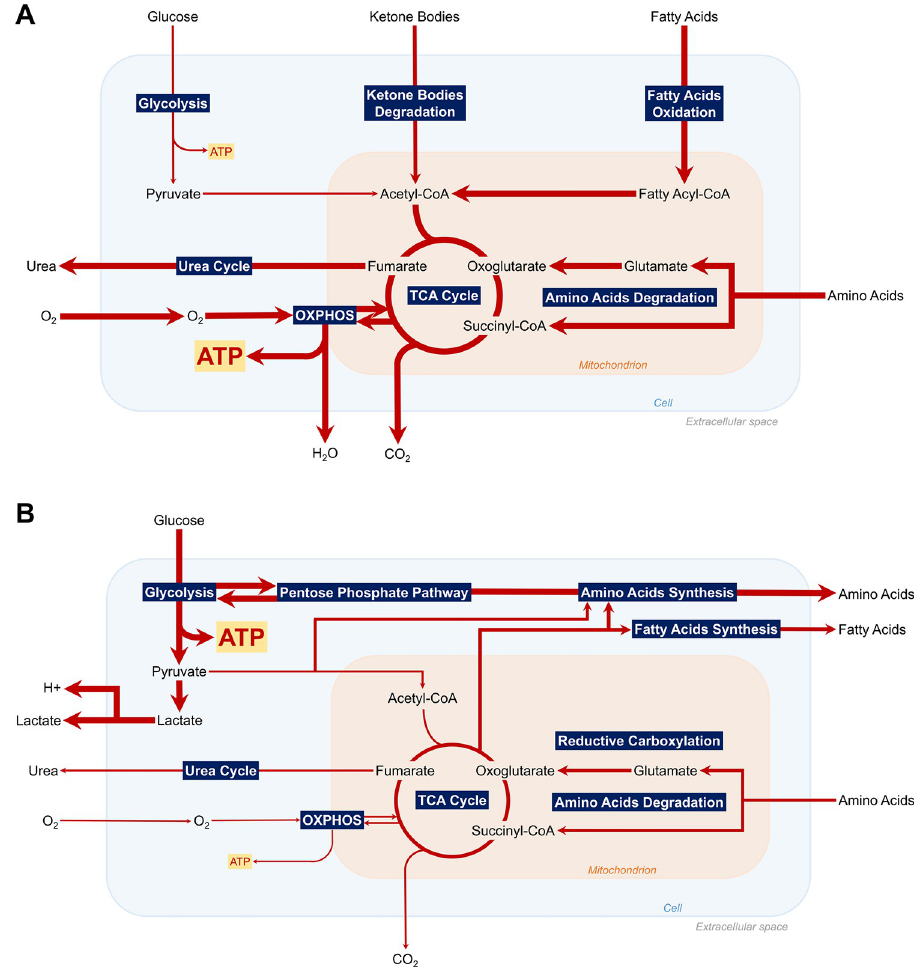
Fig 4. Summary of the major active pathways of central metabolism according to Flux Balance Analysis in control (A) and RASF-specific conditions (B) with maximum cellular ATP production as objective function.